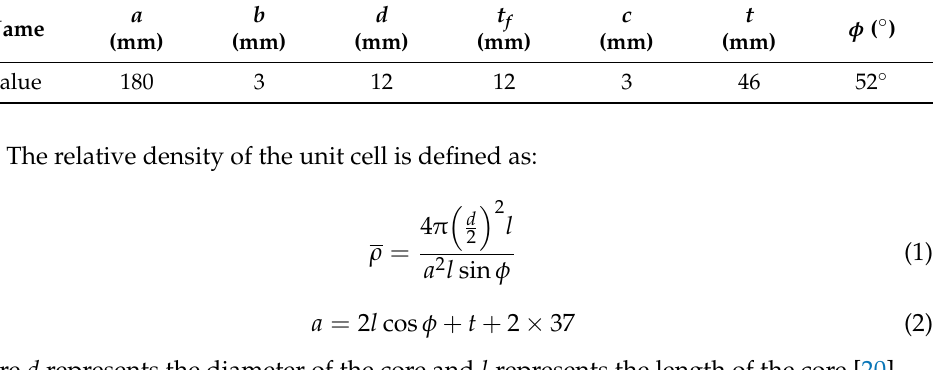
Figure 1. Unit cell of a pyramidal lattice structure. ( a ) Axonometric drawing; ( b ) Side elevation. As shown in Figure 1, l is the length of the core. d is the diameter of the core. a is the length of the panel. t f is the thickness of the panel. c is the groove width of the panel. b is the groove height of the panel. t is the distance between two neighboring points of the upper panel. φ is the included angle between the core and the lower panel. The parameters of the unit cell are shown in Table 1. Table 1. Geometric parameters of the unit cell.